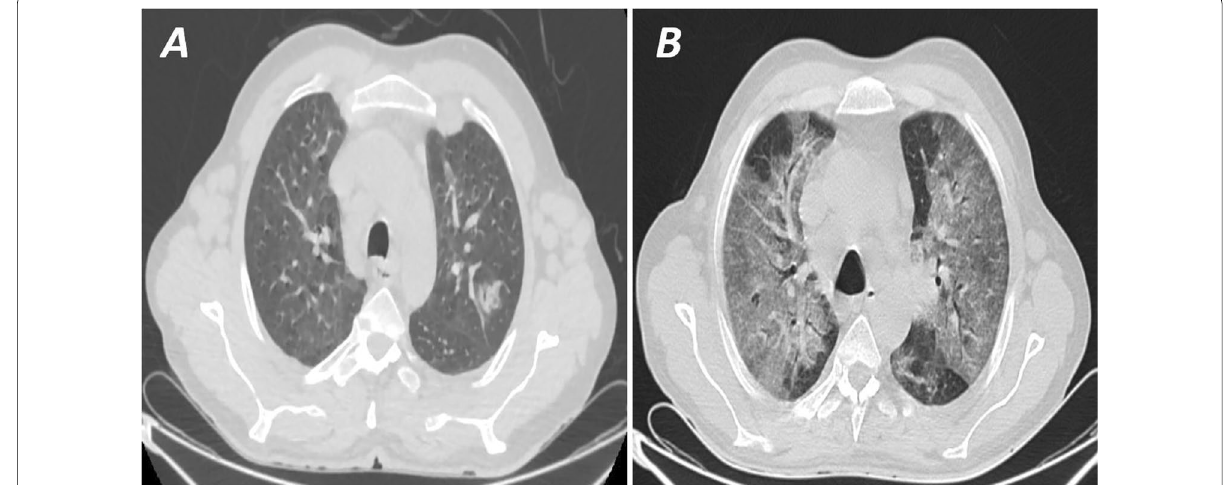
Fig. 3 A High‑resolution CT scan (axial cuts) for a 55‑year‑old male patient with recently diagnosed chronic myeloid leukemia presented with fever. The initial CT was interpreted as atypical for COVID (CO‑RADS 2) with two patches of subsegmental consolidation in the left lobe and lingual. RT‑PCR was positive for COVID‑19. B CT scan was done nine days later after the patient developed desaturation shows a picture of non‑cardiogenic pulmonary edema (ARDS), and the patient died a few days